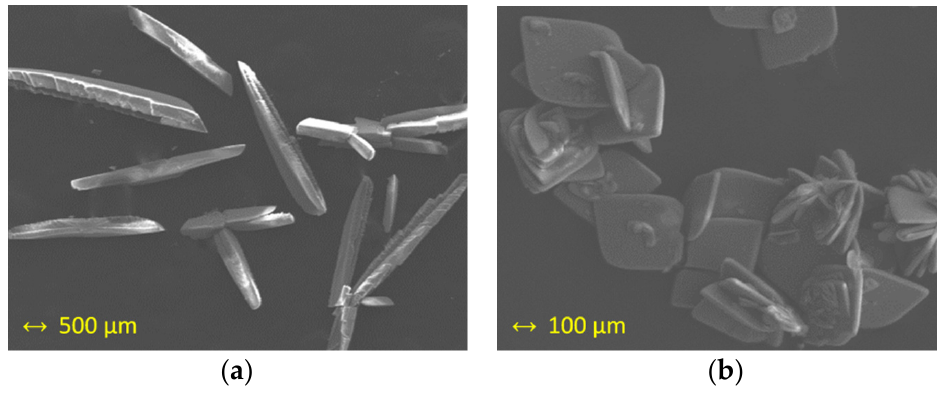
Figure 3. Scanning electron microscopy (SEM) images of: ( a ) crystals of 1a ; ( b ) crystals of 1b .